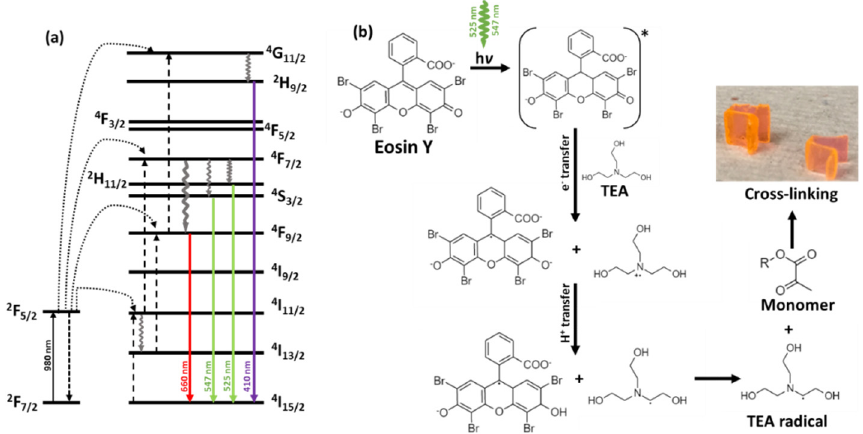
Figure 1. ( a ) Energy level diagram of UC processes in phosphors co-doped with Er 3+ and Yb 3+ ; ( b ) schematic diagram of type II photoinitator system based on Eosin Y, used for cross-linking via green UC emissions (* denotes the exited state of Eosin Y).